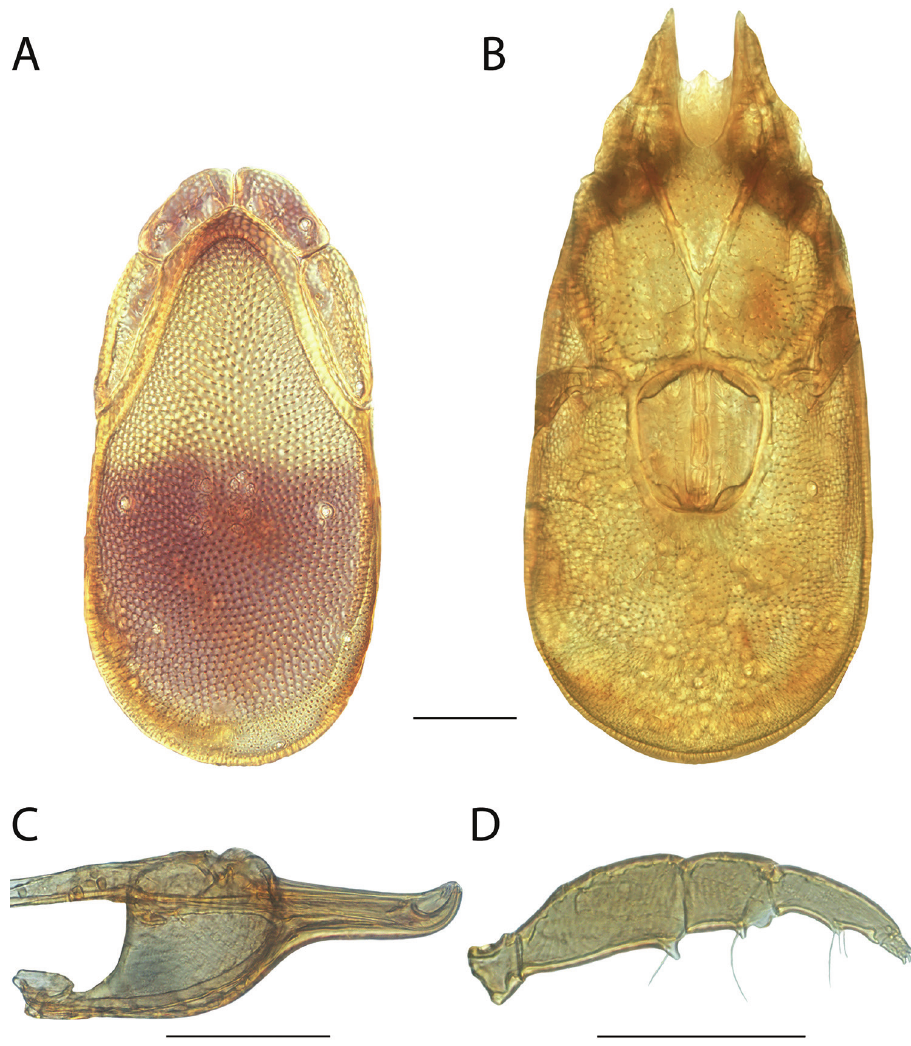
Figure 68. Torrenticola elongata sp. n. female: A dorsal plates B venter (legs removed) C subcapitulum D pedipalp (setae not accurately depicted). Scale = 100 µm.